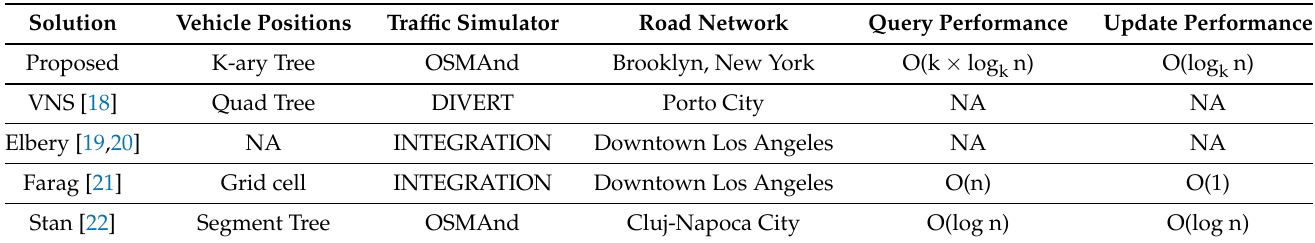
Table 1. Large Scale Traffic Simulation Solutions.